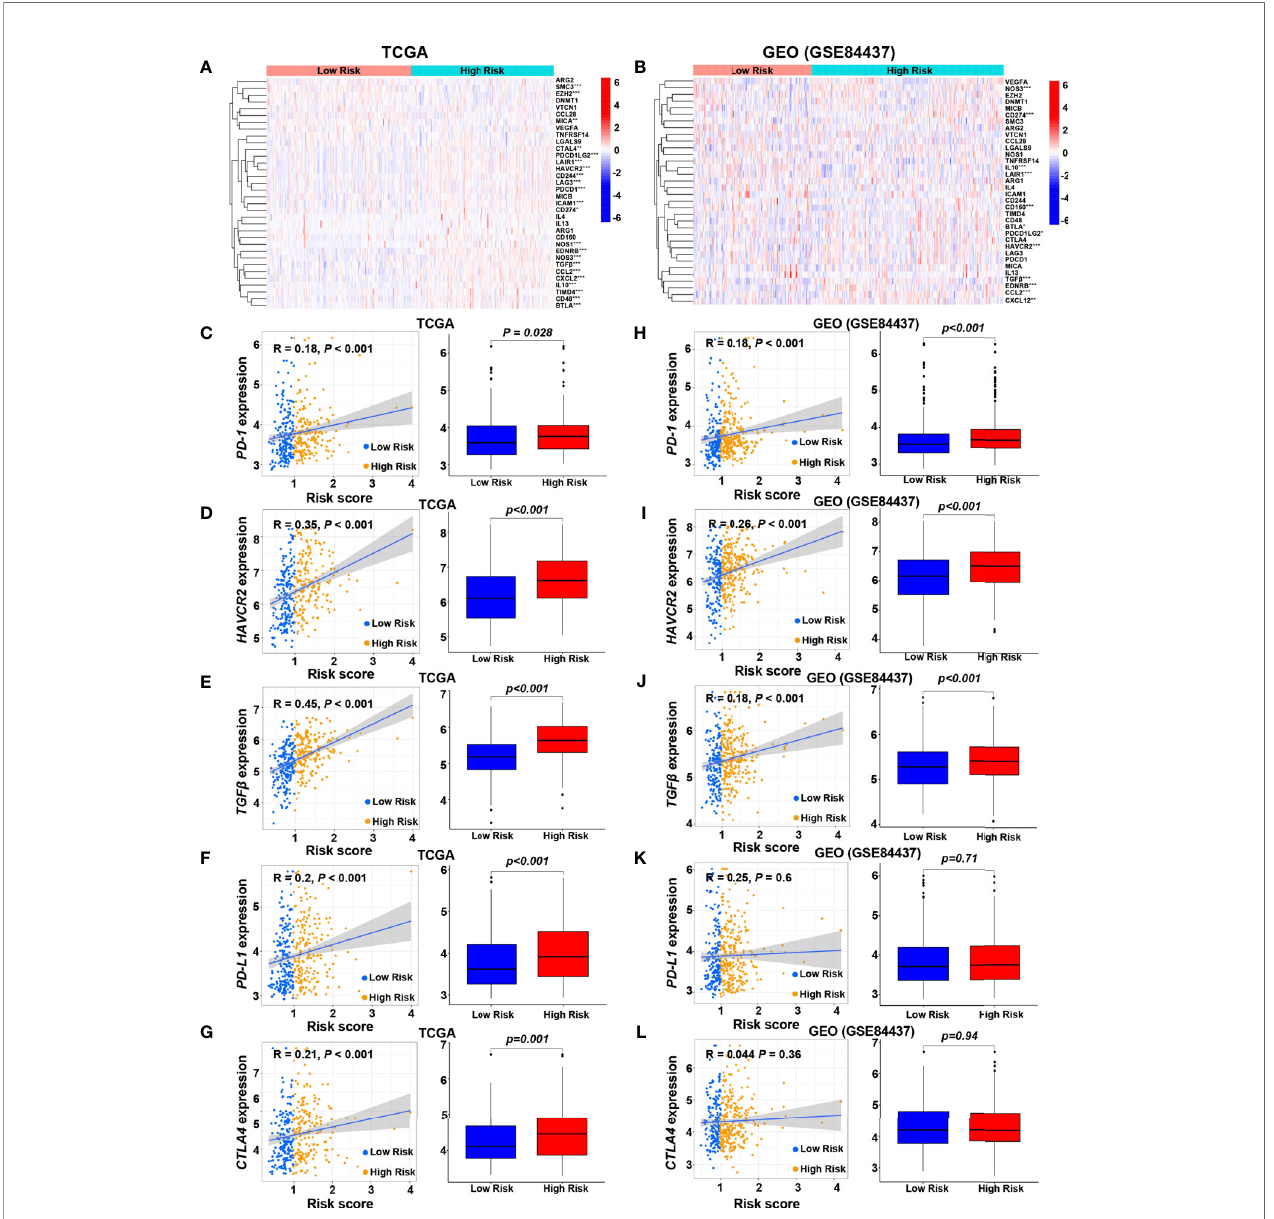
FIGURE 5 | Relationships between hypoxia risk score and immune checkpoint molecules. (A, G) Heatmaps show the expression level of immune checkpoint molecules in high-risk and low-risk groups in the screening and validation cohorts (* P < 0.05; ** P < 0.01; *** P < 0.001). Scatter plots and box plots show the relationship between the risk score and the expression level of (B, H) PD-1 , (C, I) HAVCR2 , (D, J) TGF- b , (E, K) PD-L1 , and (F, L) CTLA4 in the screening and validation